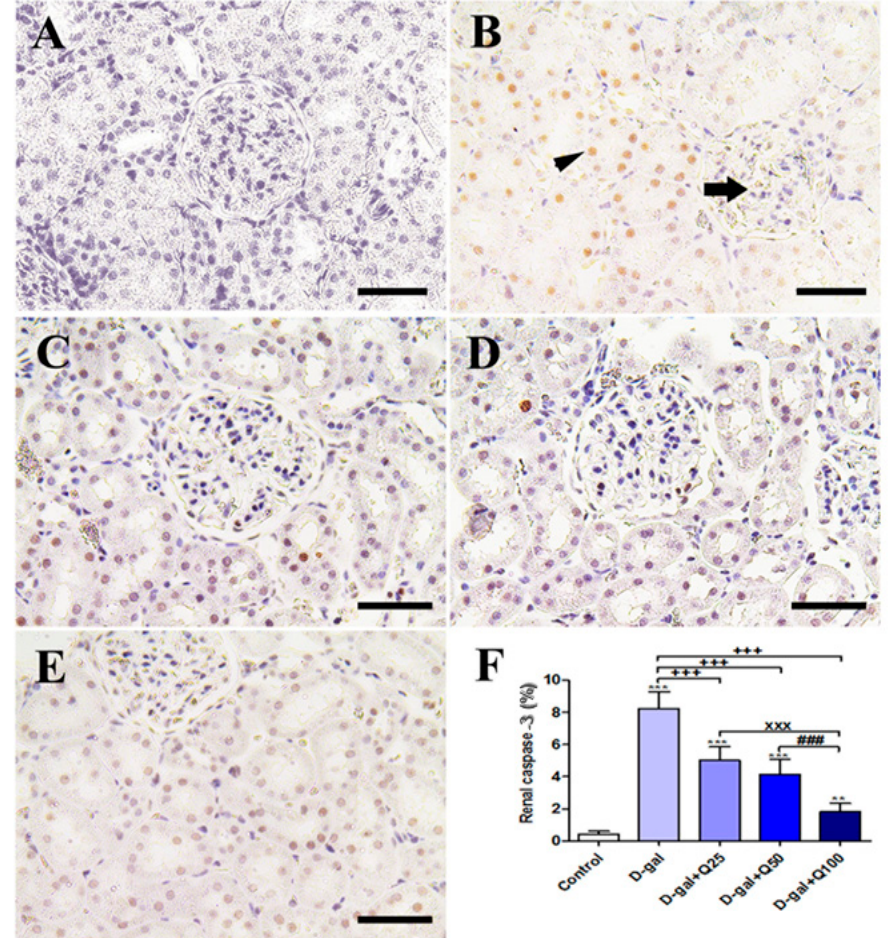
Figure 9. Immunohistochemical staining of rats’ kidney with caspase-3. ( A ) Negative control group. ( B ) The D-gal group revealing a strong caspase-3 reaction in the renal tubule (arrowhead) and the renal glomerulus has negative reactions (arrow). ( C ) D-gal+Q25 group. ( D ) D-gal+Q50 group. ( E ) D-gal+Q100 group. ( F ) Quantification of caspase-3 in the renal tissues in different groups. Scale bar = 50 µm . Data were analyzed with one-way ANOVA followed by Tukey’s multiple comparison test. Error bars represent mean ± SD. ** p < 0.01 and ** *p < 0.001 vs control. +++ p < 0.001 vs D-gal. xxx p < 0.001 vs D-gal+Q25. ### p < 0.001 vs D-gal+Q50.